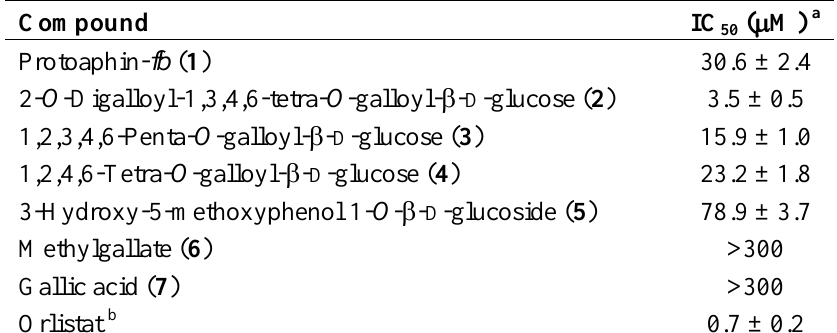
Table 1. Pancreatic lipase inhibitory activity of compounds 1 – 7 .